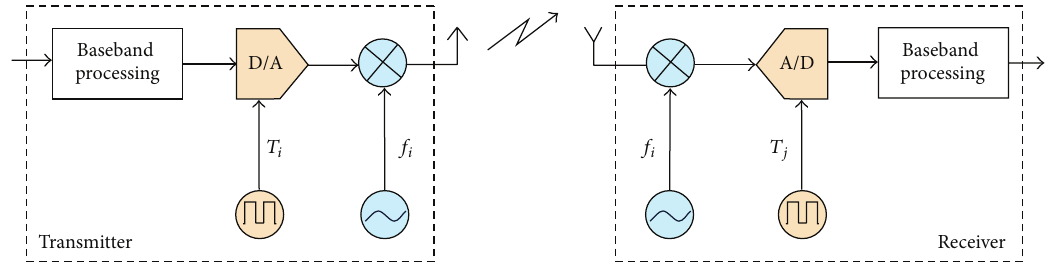
Figure 1: Transmitter and receiver have individual sampling periods 𝑇 𝑖 and 𝑇 𝑗 for digital-to-analog and analog-to-digital conversion and individual carrier frequencies 𝑓 𝑖 and 𝑓 𝑗 for upconversion and